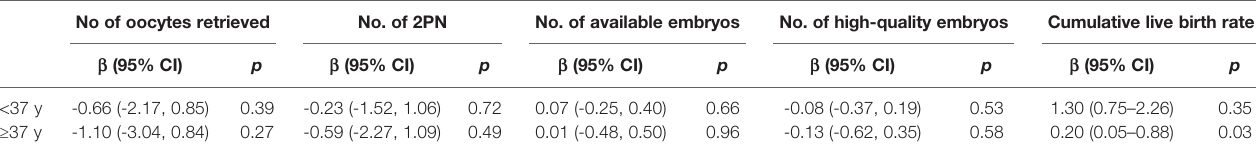
TABLE 3 | Hierarchical analysis of the pregnancy outcomes basing on age between the patients with or without the premature LH rise. No of oocytes